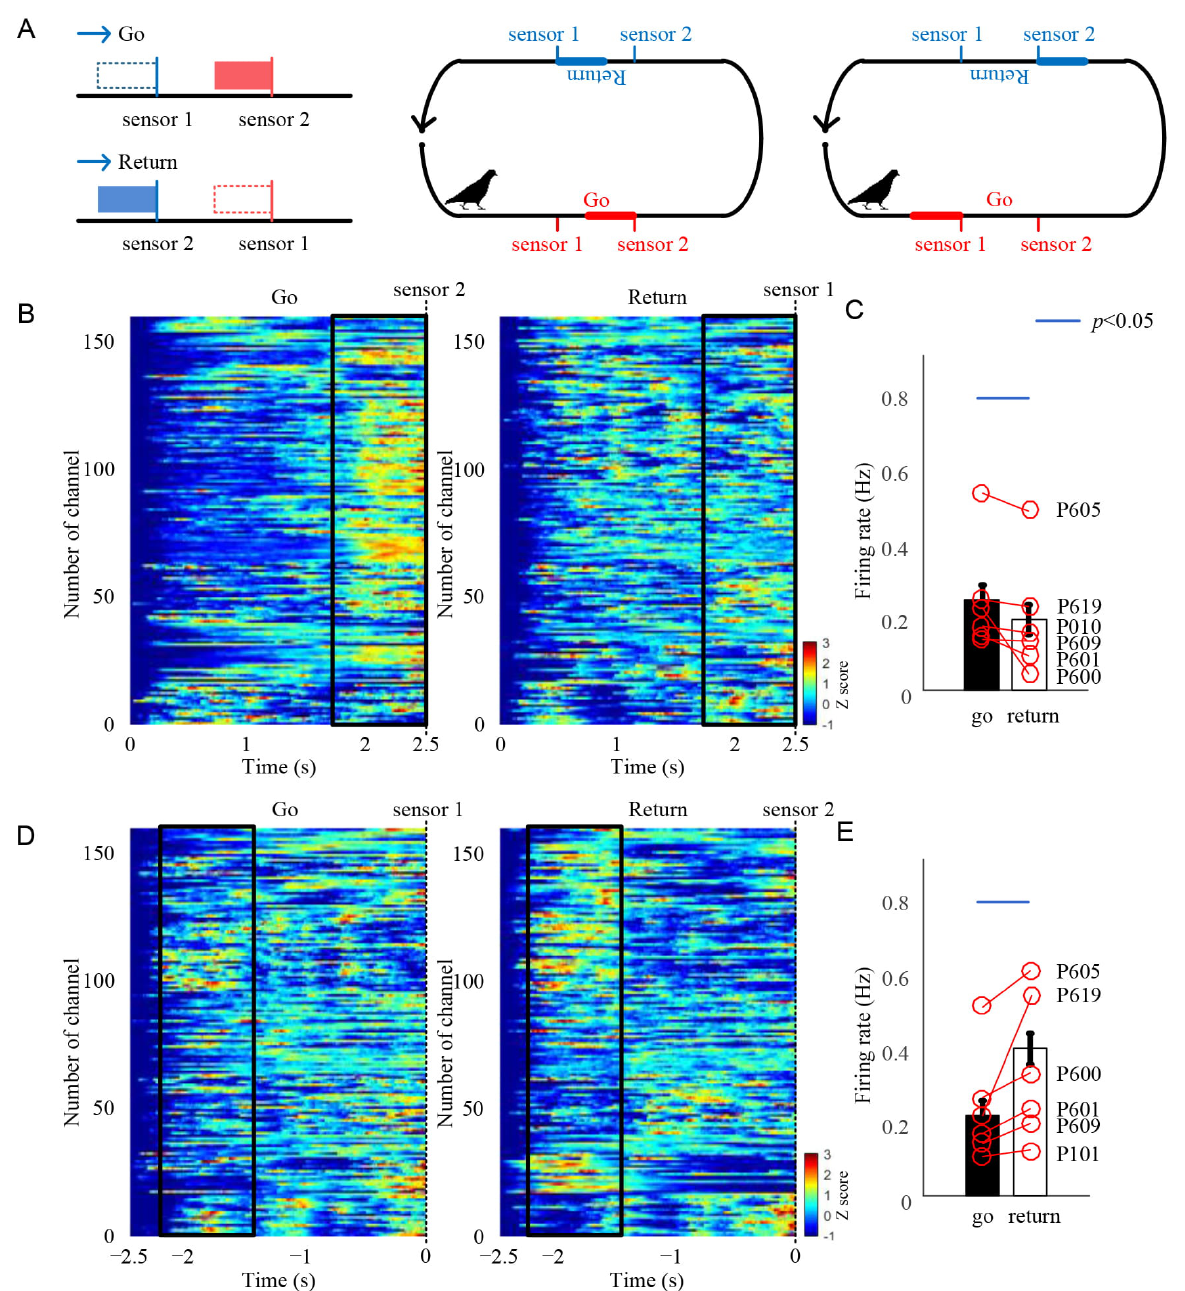
Fig. 4. NCL neural activities include decision-making information. (A) Diagram of the location of decision-making. Left: the location of decision- making is shaded by a rectangle, and the dotted line is the relative location of the decision-making window. Middle and Right: diagram of the location of the window (2.5 s) for calculating the firing rate in (C) and (E), respectively, which is shaded with the color lines. (B) and (D) The average, Z -scored activity of a single task-modulated channel. Time is measured from sensor 1 in the going (left) and sensor 2 in the returning (right). Individual channels ( n = 160) are numbered on the y-axis. Colors depict instantaneous neural firing rates (0.1-s bins) averaged across all trails. The black boxes highlight their differences. (C) and (E) Comparison of firing rate between going and returning in different windows. The data was normalized by its maximum value. The (C) conforms to the middle, and the (D) corresponds to the right sub-figure in (A). Each red line denotes a pigeon. Error bars indicate